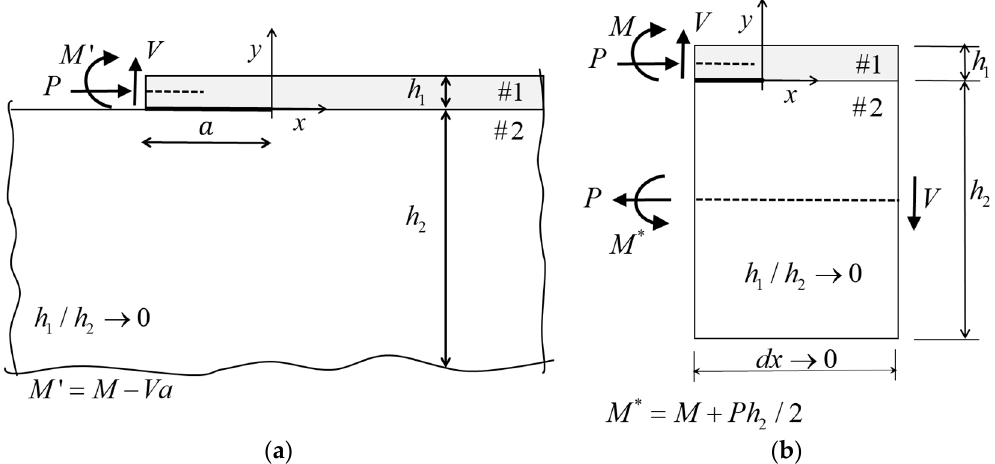
Figure 1. ( a ) An edge-delamination crack between a thin layer and a semi-infinite half-plane subject to edge loading per unit width, P , M (cid:48) , V , with M (cid:48) = M − Va . ( b ) The crack tip element with elementary loads per unit width P , M , V . #1 and #2 indicate the materials of layer and substrate with α (cid:54) = 0 and β (cid:54) =